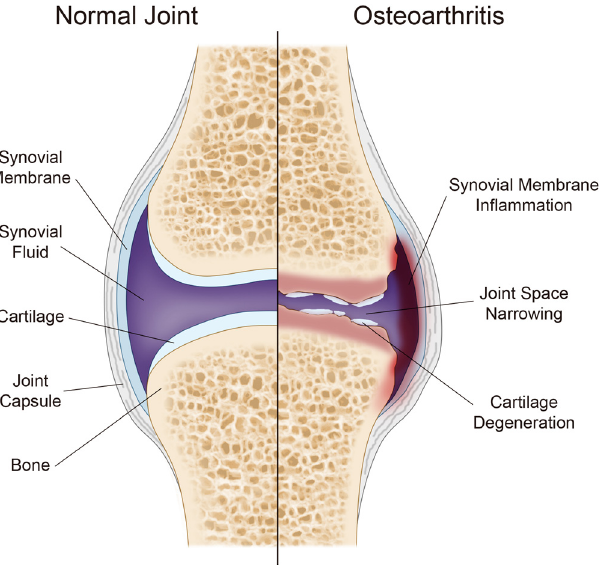
Figure 3. Structural image of normal and OA-diagnosed joints. OA mainly affects the cartilage, bone, and synovial membrane. Some prevalent symptoms that appear in OA-diagnosed joints are shown above.